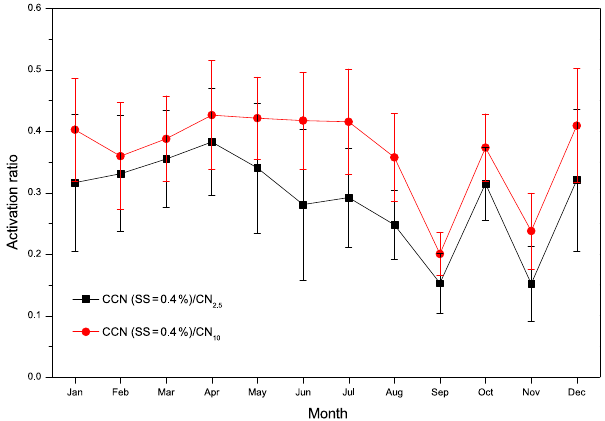
Figure 10. Comparison of the seasonal mean variation in the acti- vation ratio between measurements (CPC 3776 and CPC 3772) by two CPCs. The error bars represent the standard deviation of the measurements from the mean